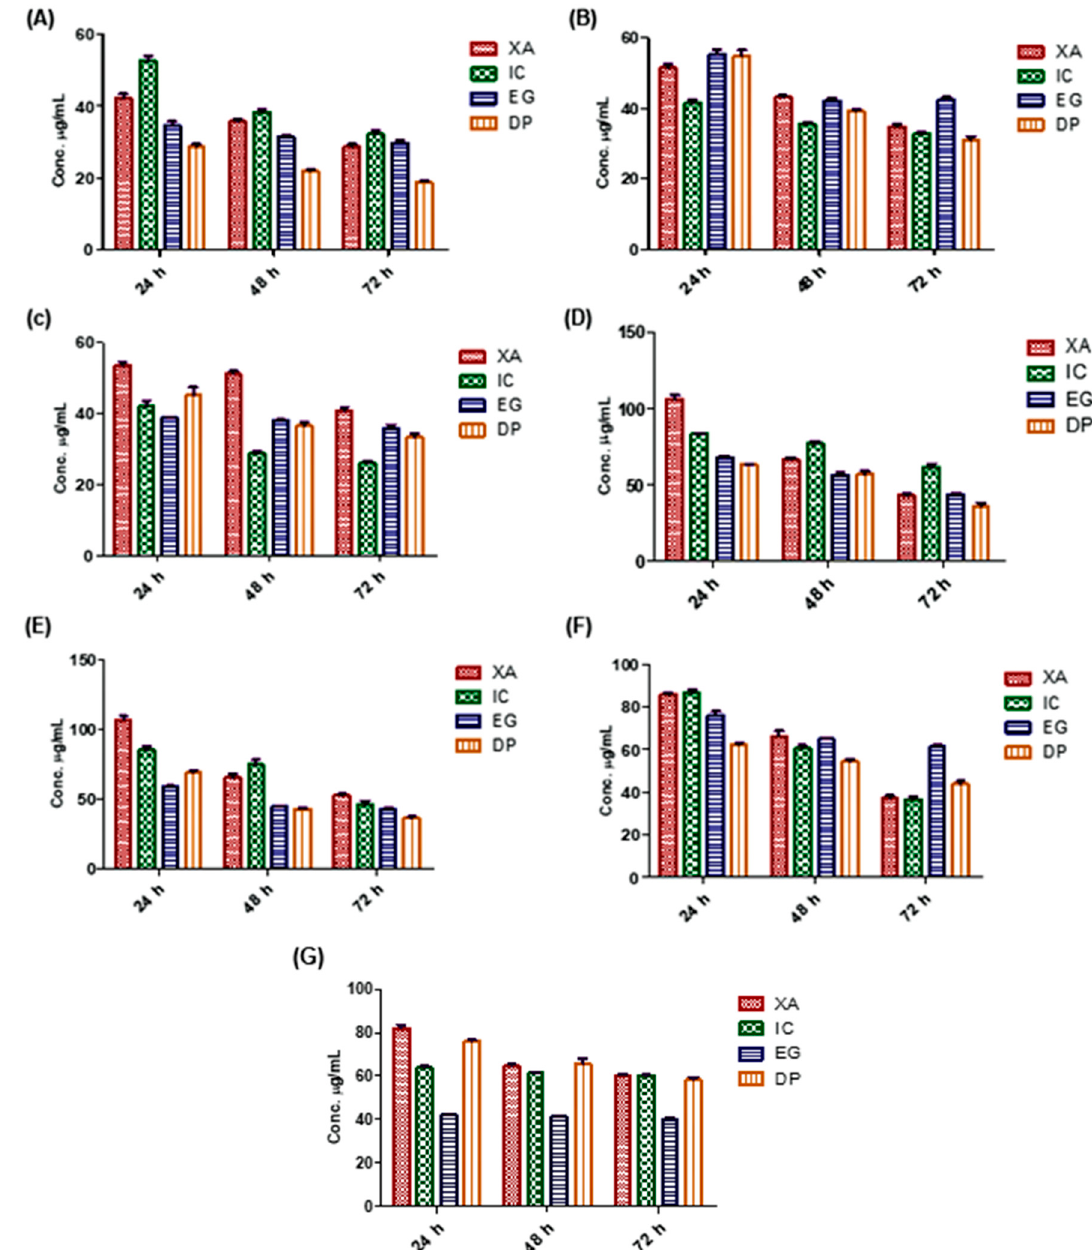
Figure 3. The cytotoxicity effect of the studied plant extracts on different cell lines over 24, 48 and 72 h using MTT assay: ( A ) HeLa, ( B ) HepG2, ( C ) MDA-MB-231, ( D ) A549, ( E ) SK-OV-3, ( F ) U-87 and ( G ) HL60, (Y-axis: the concentration of IC 50 in µg/mL). Values are mean ± SD of three independent experiments.